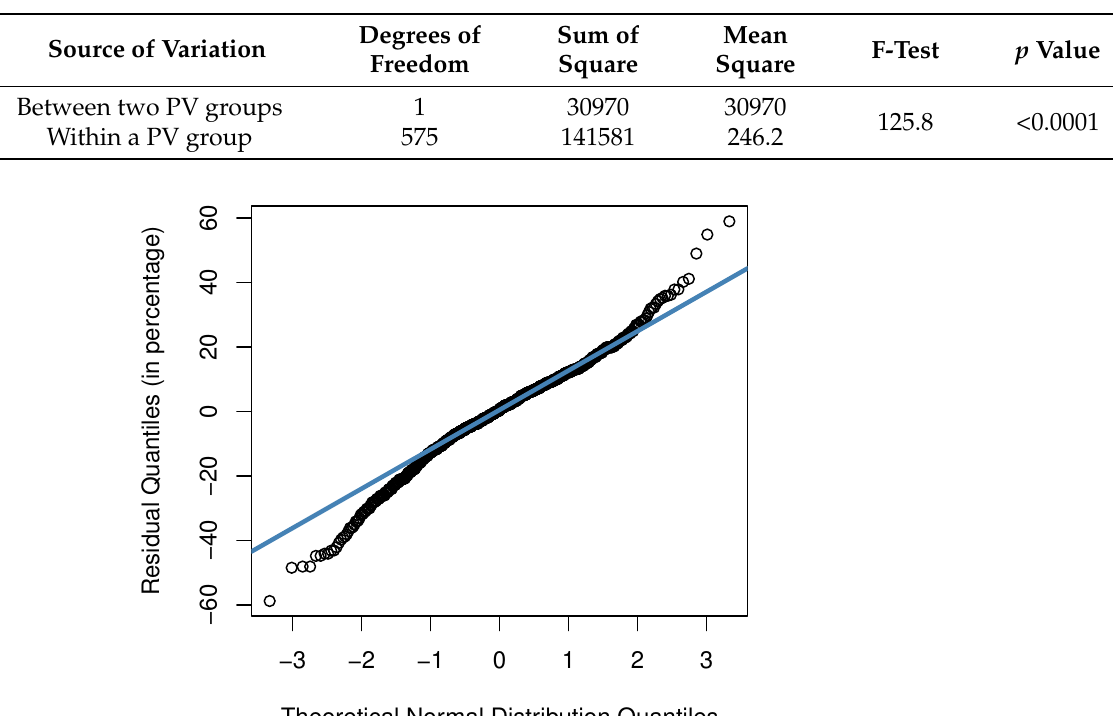
Table 5. The analysis result from the ANOVA test.